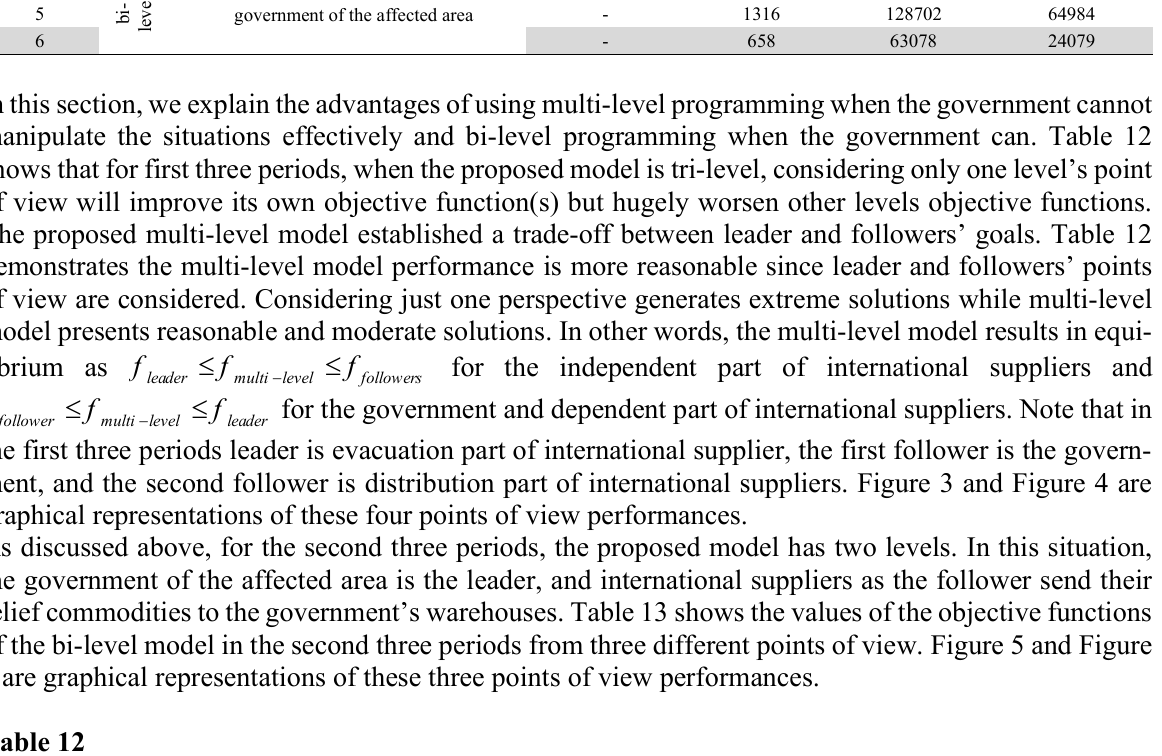
Objective functions of the proposed model from different points of view for first three periods. Leader